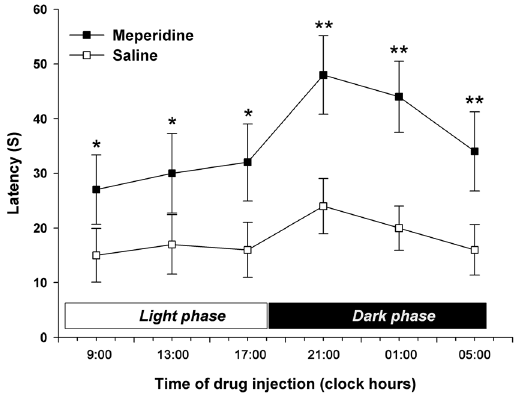
Figure 2. The 24-h rhythm of analgesic effect after meperidine injection. Full legend: The 24 h rhythm of analgesic effect after meperidine (20 mg/kg i.p.) ( & ) or saline ( % ) injection. Each value represents the mean with SD. * P , 0.05, ** P , 0.01 compared with the saline group using Scheffe’s test.